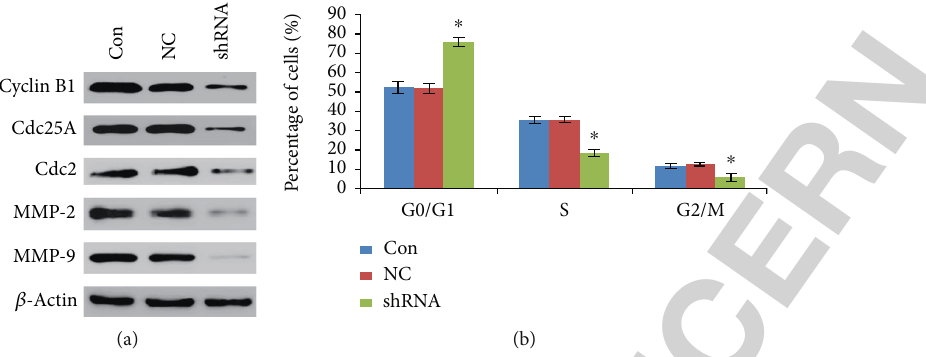
Figure 5: (a) Inhibition of LOXL1-AS1 expression reduced expression of some cell cycle protein and tumor metastasis-associated protein. Western blot analysis revealed the signi fi cantly reduced expression levels of Cdc2, Cdc25A, cyclin B1, MMP-2, and MMP-9 in the si- LOXL1-AS1 group compared with the NC and Con groups. (b) E ff ect of LOXL1-AS1 knockdown on cell cycle progression. The knockdown of LOXL1-AS1 resulted in a signi fi cant increase in the percentage of cells in the G0/G1 phase. Graph revealed mean ± SD , ∗ meant P < 0 : 05